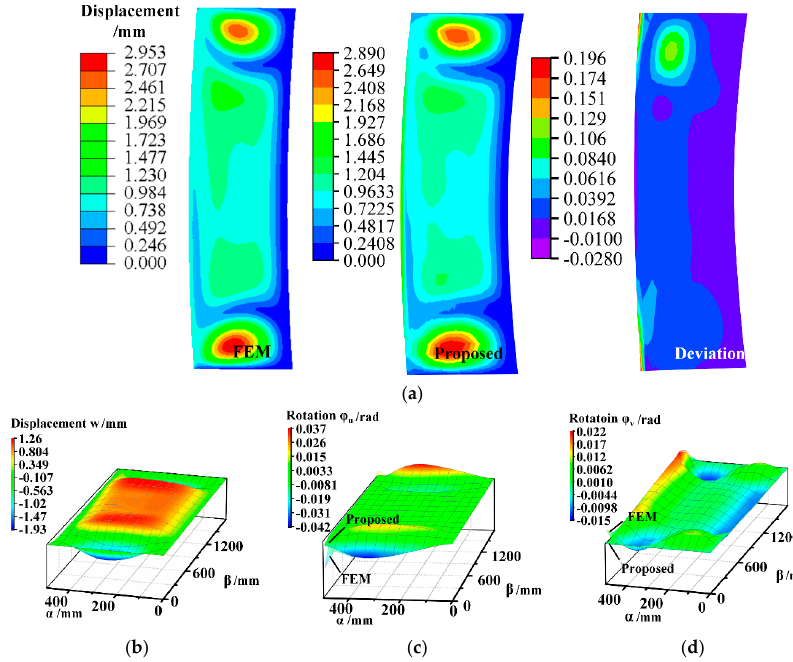
Figure 4. Displacement and rotation of the deformed shell middle surface. ( a ) Magnitude of displacement; ( b ) displacement in direction of γ ; ( c ) rotation around axis α ; ( d ) rotation around axis β .